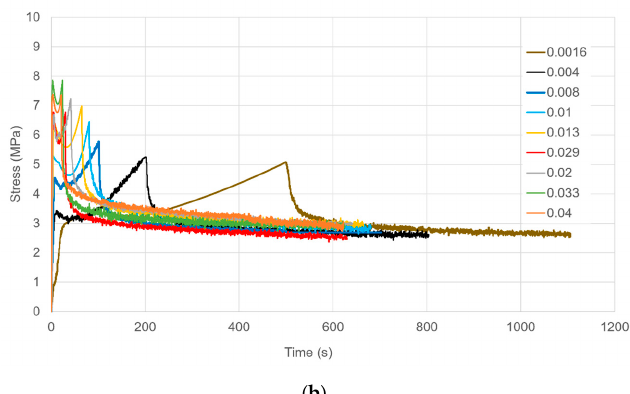
Figure 4. Axial ( a ) and transverse ( b ) true stresses for loading and stress relaxation in planar extension. They key shows octahedral strain rates in s − 1 .